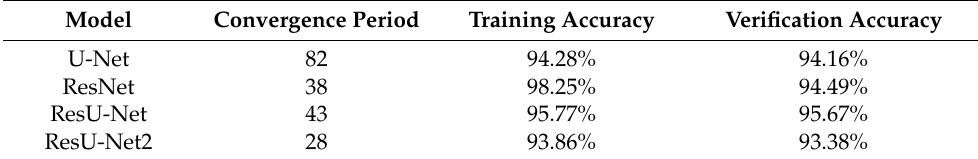
Table 4. The convergence period, training accuracy, and verification accuracy of the models.